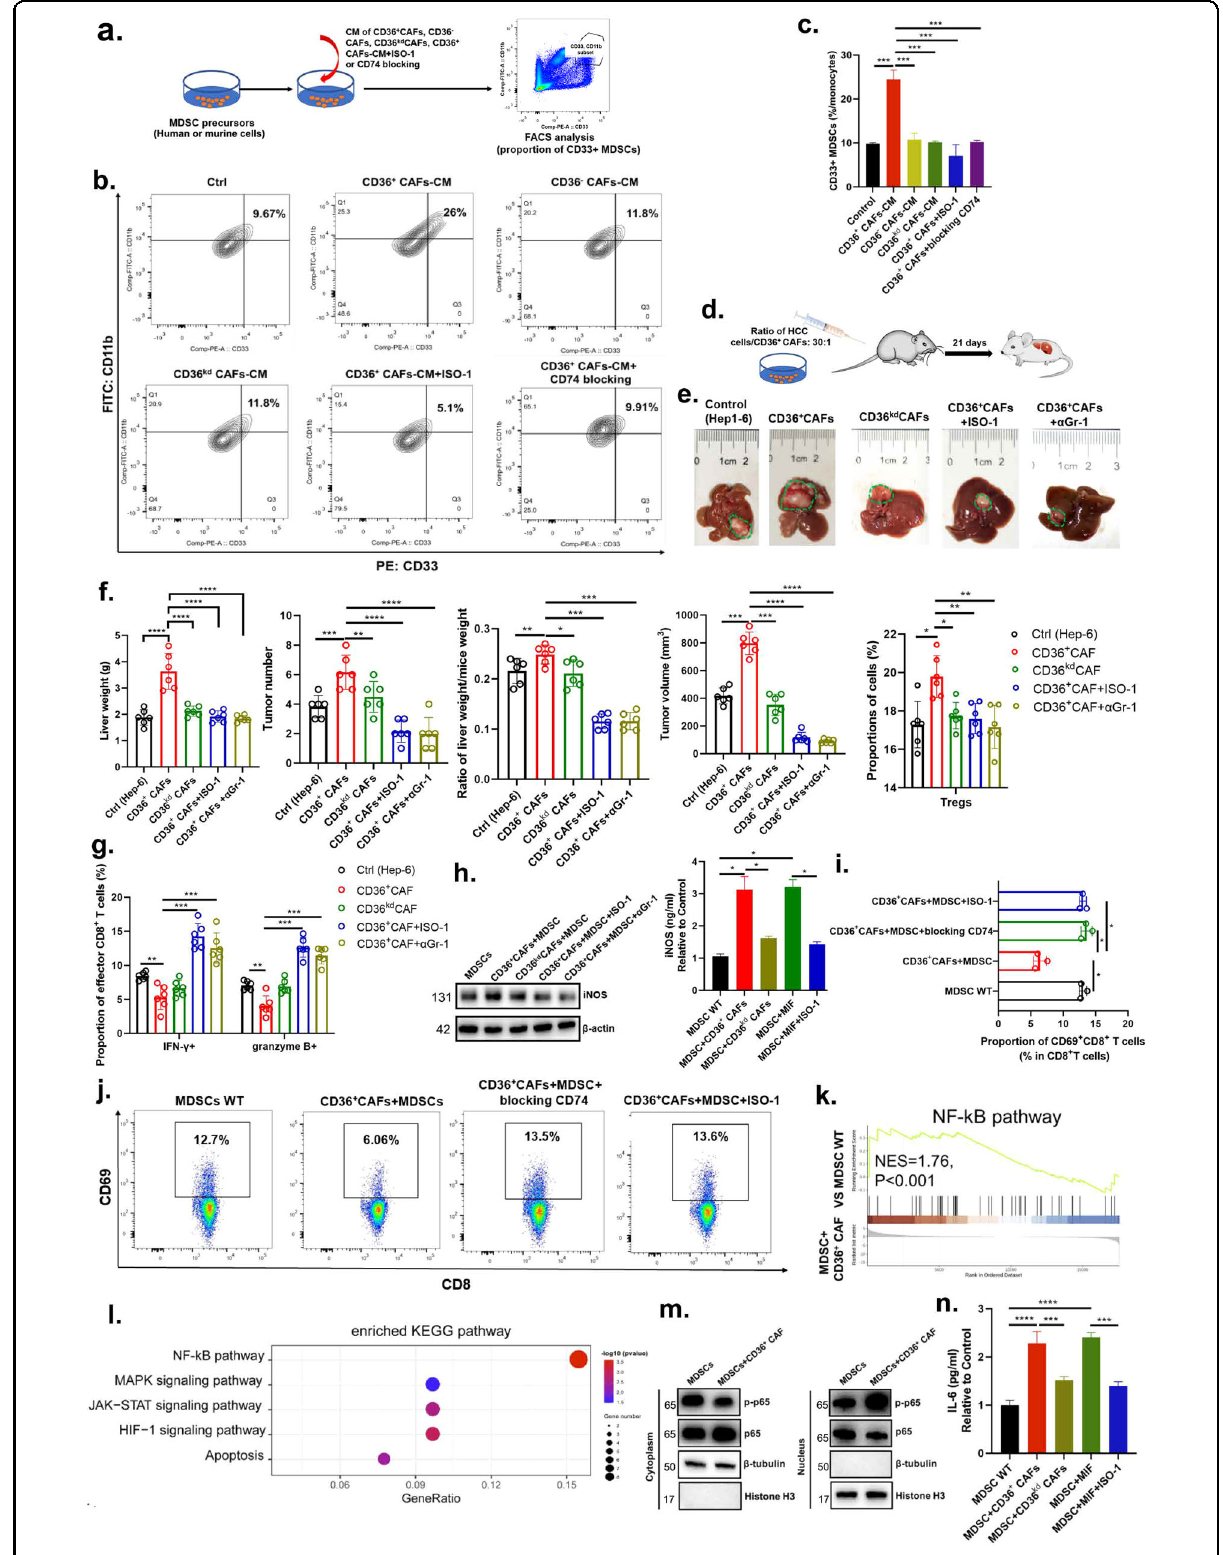
Fig. 5 (See legend on next